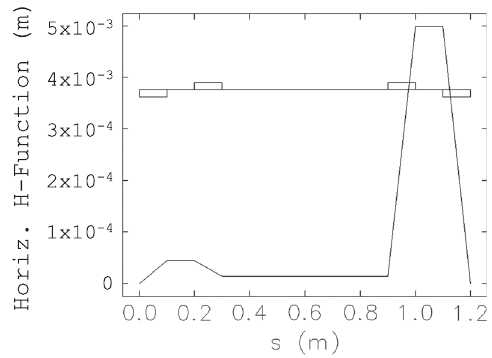
FIG. 8. Horizontal H function in NIEM at 286 MeV.